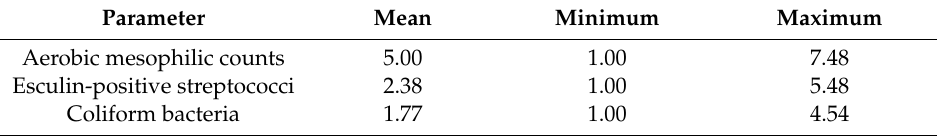
Table 2. Bacterial counts (log 10 cfu / mL) of 120 pooled wet–dry teat-skin samples. Parameter